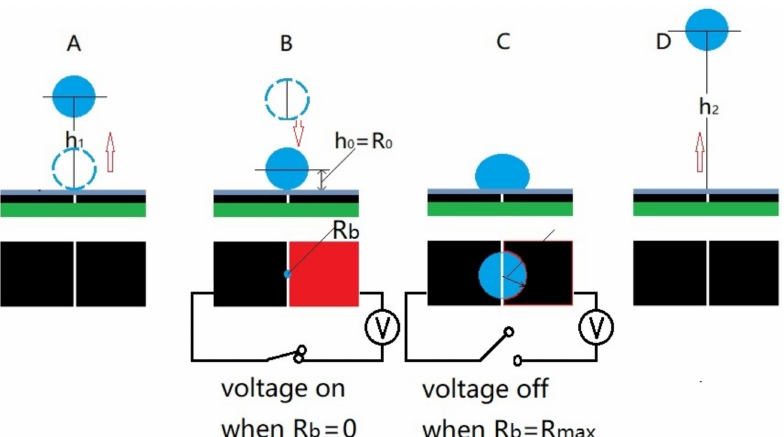
Figure 2. Schematic diagram of trampolining the droplet using electrowetting. With ( A – D ) showing the 1st jumping, impacting, spreading, and 2nd detaching of the droplet. The red and dark colors in ( B ) represent the driving and reference